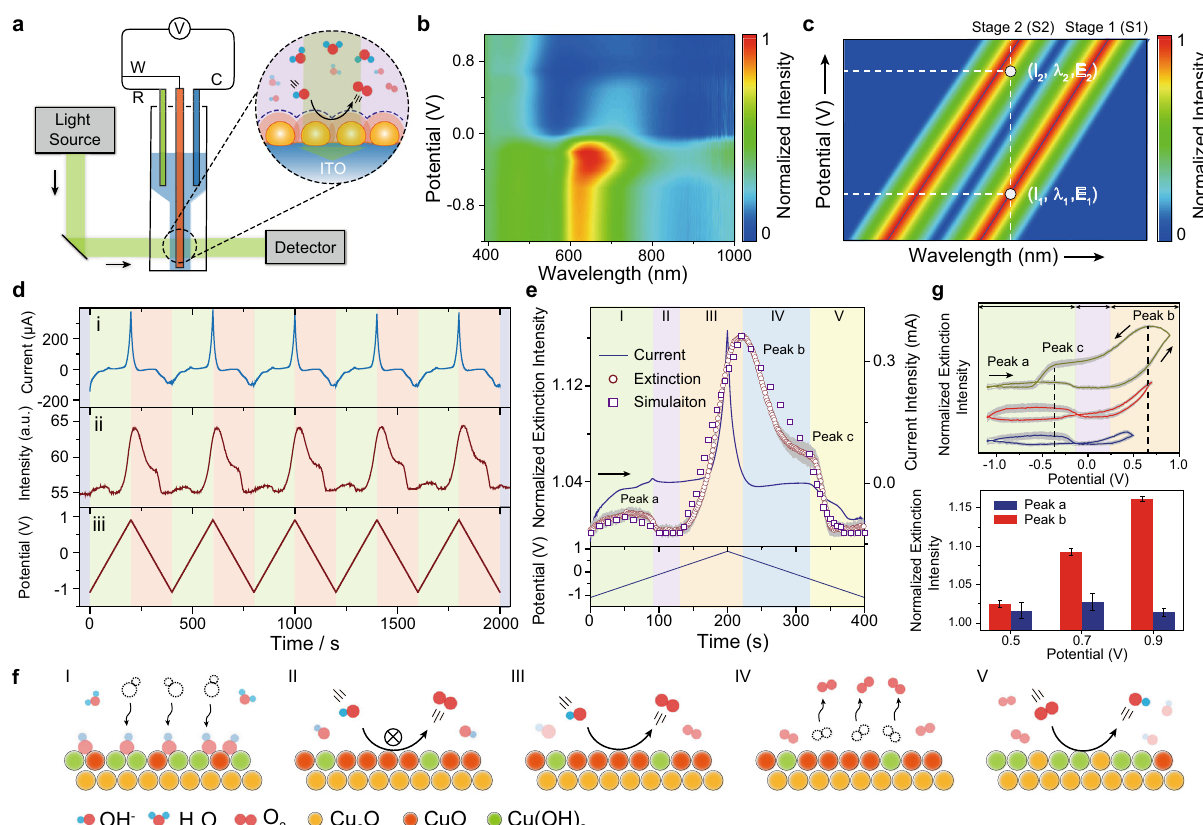
Fig. 2 Plasmonic monitoring oxygen evolution reaction. a Experimental setup of in situ electrochemical extinction microscopy. b The normalized dynamic extinction intensity (contour plots) of a Cu NPs electrode under steady-state anodic polarization. c Schematic illustration of the plasmonic single- wavelength strategy for real-time monitoring OER at the EEIs. d The consecutive electrochemical current (i) during OER and synchronous extinction signal (ii) under dynamic potential scan (iii). e The representative dynamic extinction trajectory ( ο ), current curve ( − ), and FDTD simulation ( □ ) for OER on a plasmonic Cu NPs electrode scanned from − 1.10 to 0.90 V at a scan rate 0.01 V s − 1 . f Schematic illustration of the interfacial reaction mechanism during dynamic potential scan. Note that both copper oxides and hydroxides serve as the real reactive species to react with OH − and then generate oxygen. g The extinction voltammetry with different terminational potential (0.50, 0.70, 0.90 V) at a scan rate of 0.01 V s − 1 (top panel). The dark region represents the standard error during consecutive fi ve scan. The potential dependent of extinction intensity for peak a and b (bottom panel). Error bar represents the SE during consecutive fi ve